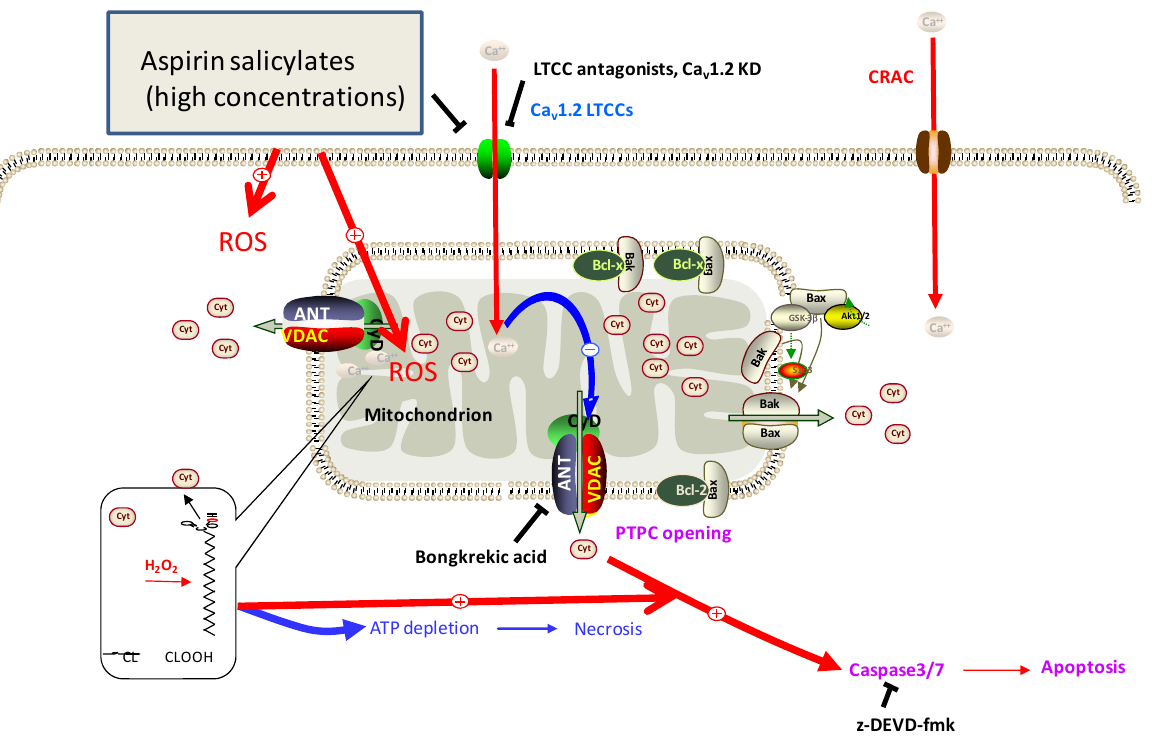
Figure 3. Proposed model for the apoptosis-inducing effects of